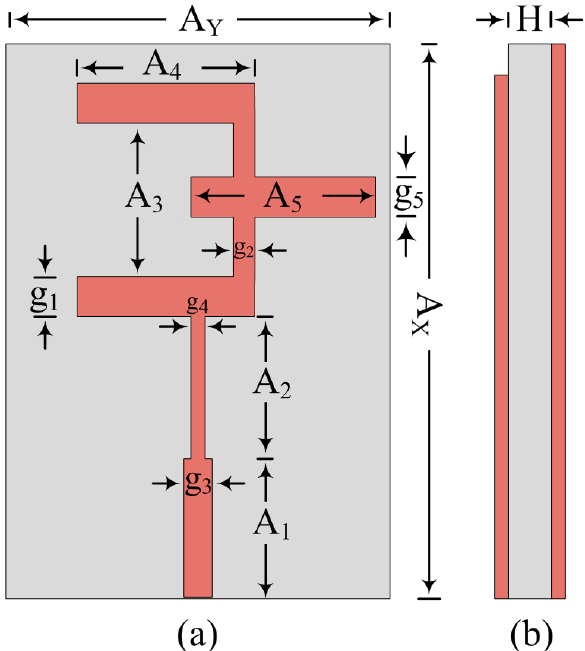
Figure 1. Antenna schematic ( a ) top-view ( b ) side-view.